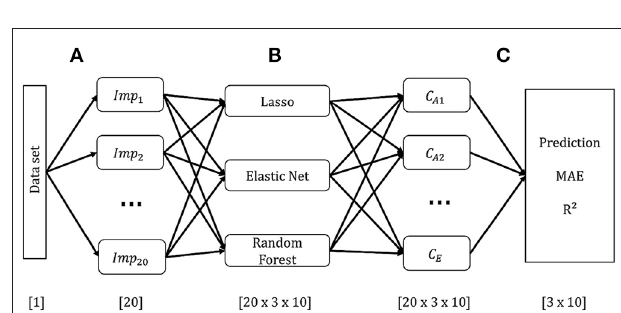
FIGURE 2 | Schematic overview of the model-building pipeline. Numbers in brackets indicate dimensions. (A) Pre-processing and generation of 20 data sets based on multiple imputation of missing values. (B) Building models on each imputed data set for each CAFPA. (C) Prediction of CAFPAs with the three selected models on each imputed data set. Evaluation of prediction accuracy using the Mean Absolute Error (MAE), and R ² averaged across multiple data